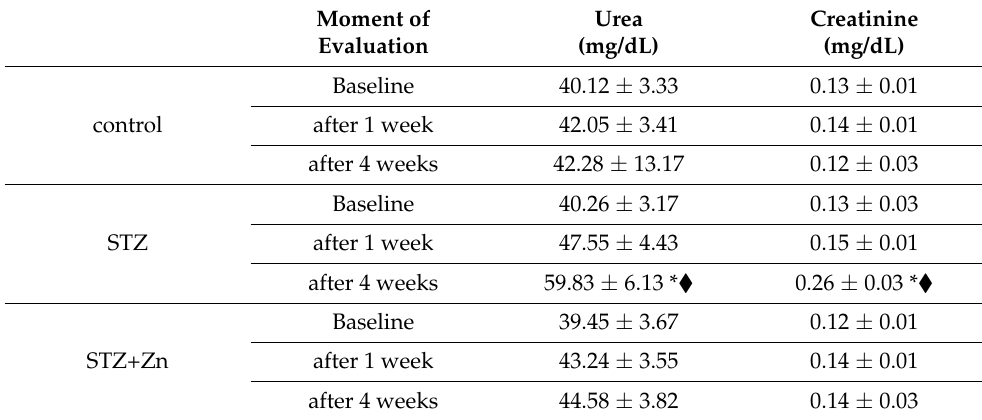
Table 6. The effects of Zn on serum levels of urea and creatinine in diabetic rats. The numbers are presented as arithmetic average ± S.D. for five animals in a group. * p < 0.05 versus control; (cid:7) p < 0.05 versus